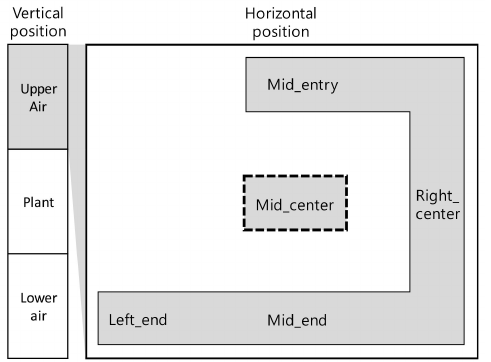
Figure 6. Schematic depicting the positions of measurements at the upper air height. The vertical position of sensors is given in the elevation view and the horizontal position is given in the floor plan view. Measurements were collected from September to 6 October 2021.